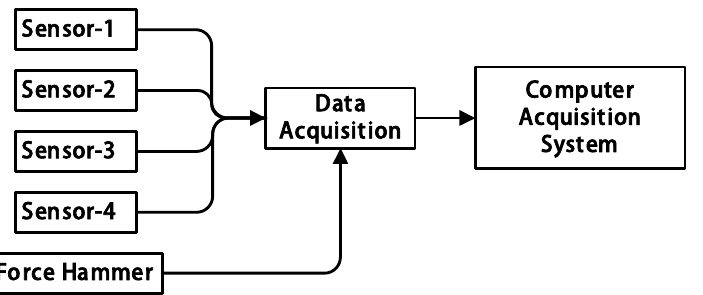
Figure 4. The configuration of the experiment system.